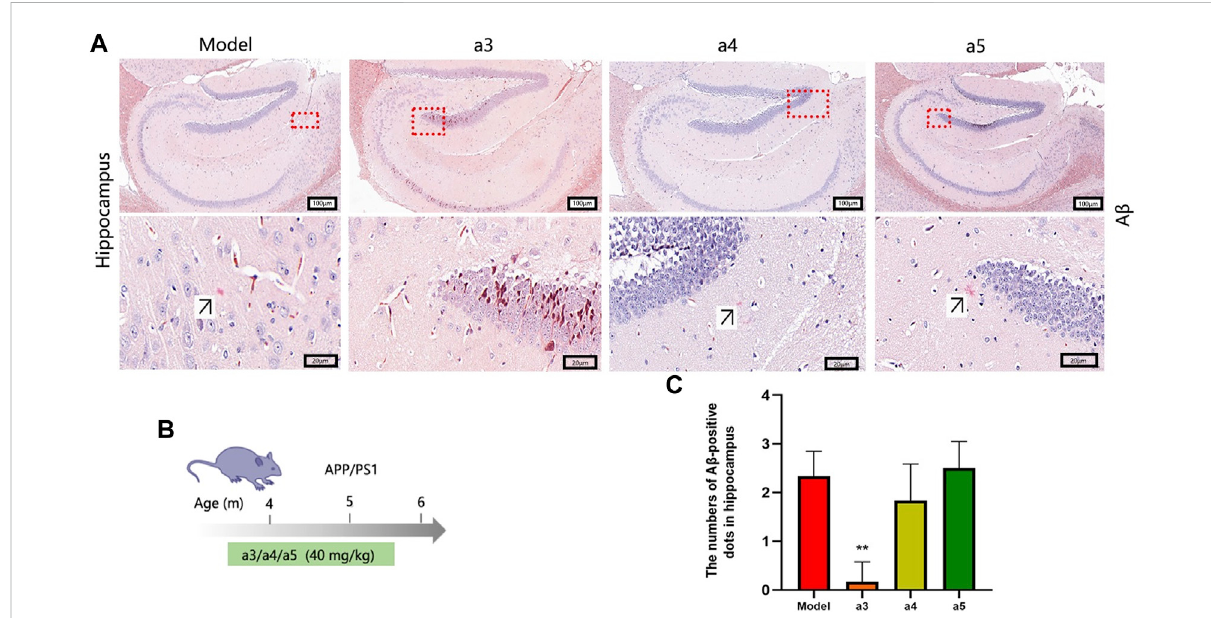
FIGURE 9 LevelsofA β depositioninthehippocampus. (A) Congoredstainingofthehippocampus. (B) SchematicoftheprotocolfordoseandtimeinAPP/ PS1 mice. (C) A β -positive dots in the hippocampus.